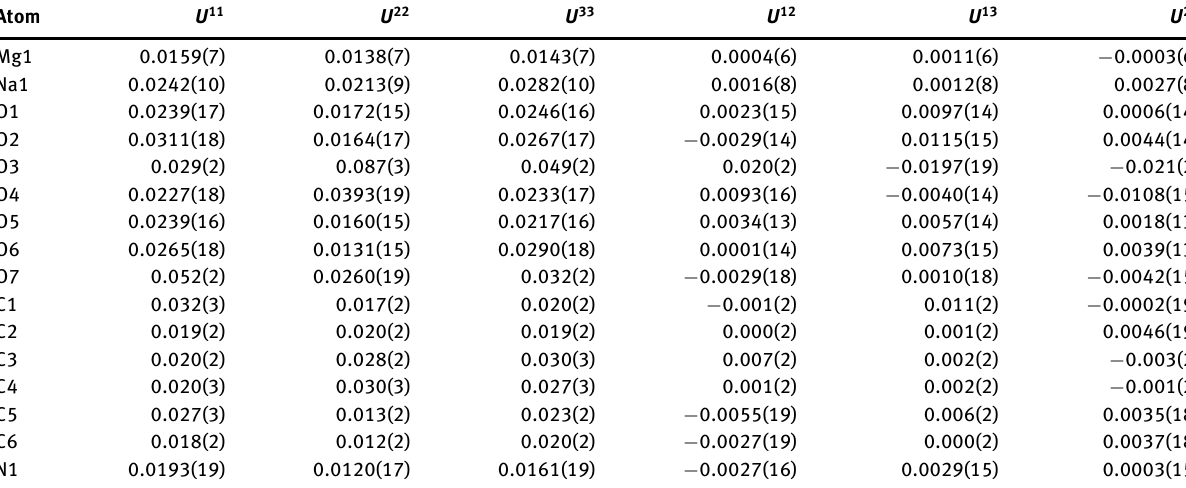
Table 3: Atomic displacement parameters (Å 2